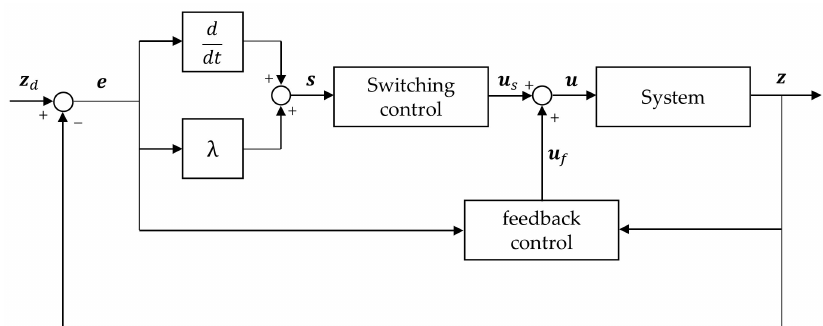
Figure 7. Block diagram of the sliding mode